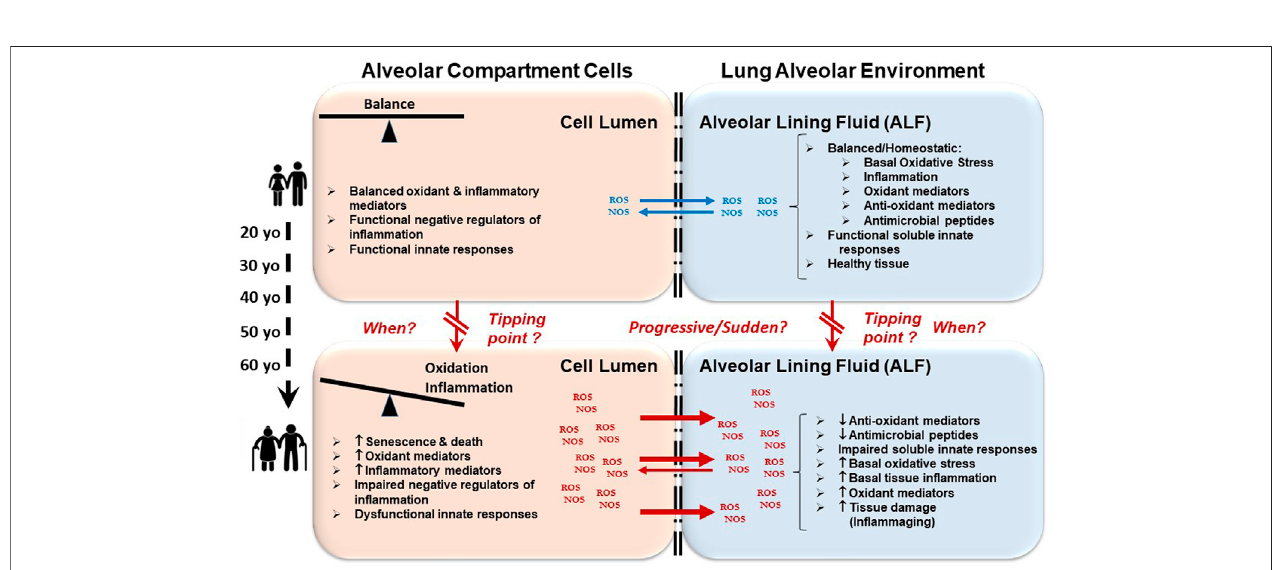
FIGURE 2 | Oxidative and in fl ammatory environment in the lung leads to immunological impartment and susceptibility to respiratory infections. As we age, cellular senescence occurs. There are also alterations in cellular metabolic processes involving energy production and consumption among others. These events lead to an accumulation of oxidative stressors (ROS/NOS) in the lumen of alveolar compartment cells (left boxes) causing increased cellular in fl ammation that cannot be ef fi ciently regulated. Subsequently, this accumulation of oxidative stressors out fl ows into the alveolar environment (e.g., upon cell death) (right boxes). This out fl ow causes lung tissue in fl ammation and damage, and also drives the oxidation and impairment of lung soluble and cellular immunomodulators. Altogether, these events contribute to the elderly becoming susceptible to acute and chronic respiratory infections and diseases.